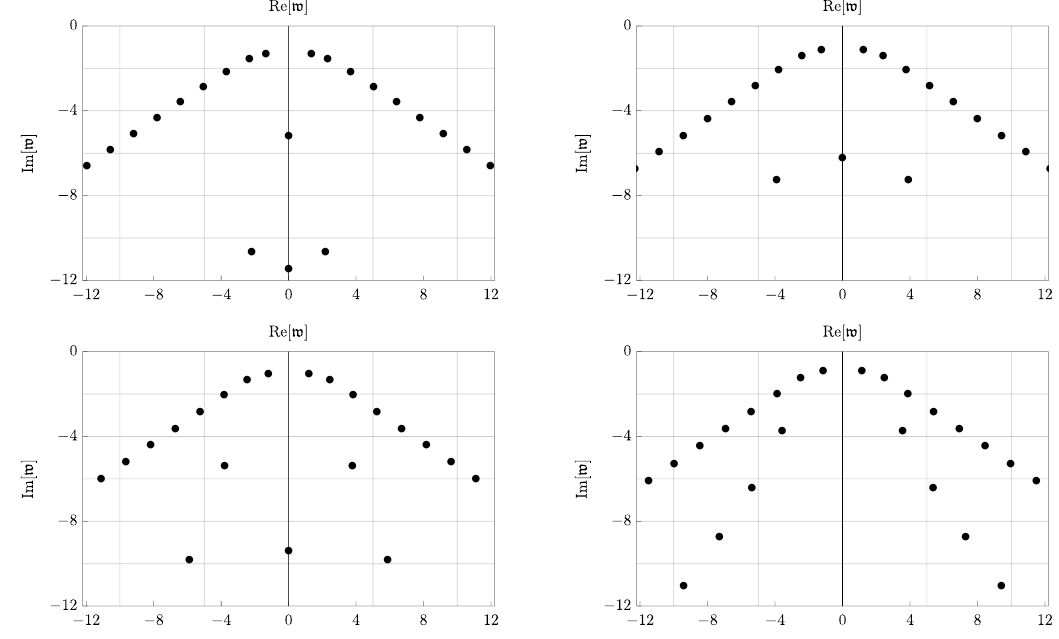
Figure 5 . The scalar channel spectrum at q = 0 : 5, plotted for (cid:11) = 0 : 02 and (cid:13) 2 = f 0 : 01, 0 : 02, 0 : 03, 0 : 05 g , from top-left, top-right to bottom-left and bottom-right.